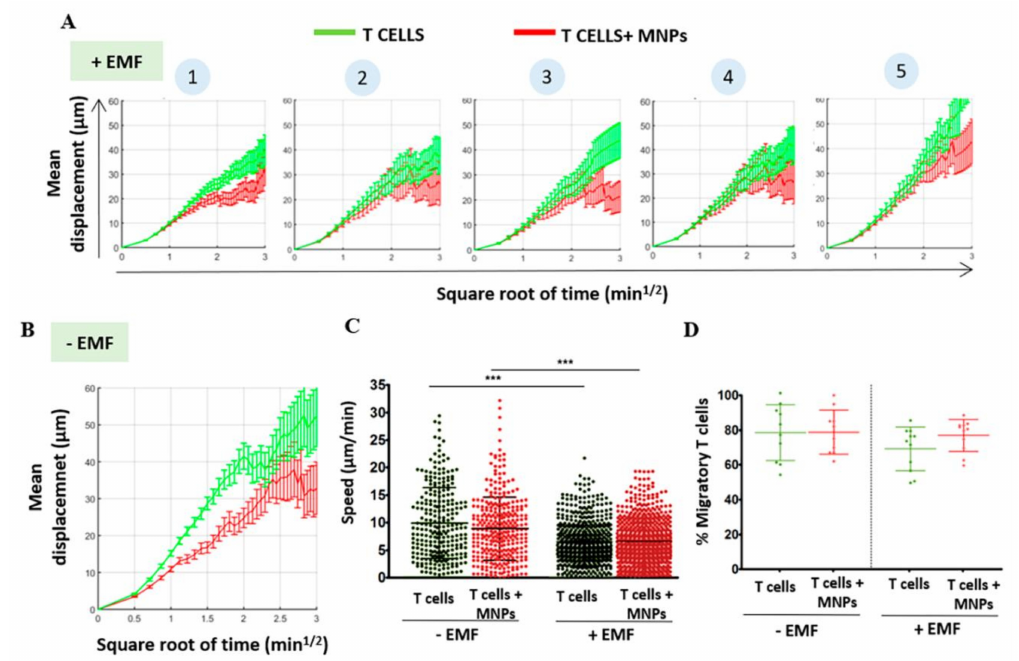
Figure 5. Analysis of the migratory capacity of murine T cells after association with MNPs and in presence of an EMF, in in vitro “under agarose” migration assays. Coverslips were coated with recombinant murine Intercellular Adhesion Molecule 1 (ICAM-1) and CCL21 and overlaid with agarose. Primary murine T cells were labelled with CellTracker orange dye (Invitrogen), injected under the agarose layer with a micropipette and allowed to polarize for 30 min prior to the EMF application. Five positions (1 to 5) were selected with the microscope at increasing distance of the applied magnet (position 1 being the closest to the magnet and position 5 being the furthest from the magnet), and T cell movement was tracked over time. Mean displacement versus time graphs of T cells in the “under agarose” assay ( A ) at increasing distances from an EMF and ( B ) in the absence of an EMF. On one hand, these results indicate that MNP treatment by itself produces alterations in the migratory capacity of murine T cells, which show a reduction in the displacement along the time compared to untreated cells. On the other hand, EMF impairs migration in both MNP-treated and untreated murine T cells in a distance-dependent manner. Quantification of ( C ) cell speed and ( D ) percentage of cells that migrate in all conditions after analyzing the movies using Imaris software. The results shown (mean ± SD) are representative of two independent experiments. Student’s t-test, *** p < 0.001. These